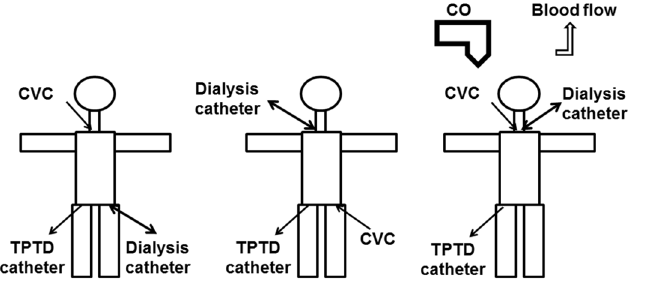
Fig 1. Potential impact of renal replacement therapy (RRT) on transpulmonary thermodilution (TPTD) with potential impact of catheter positions and blood flow.